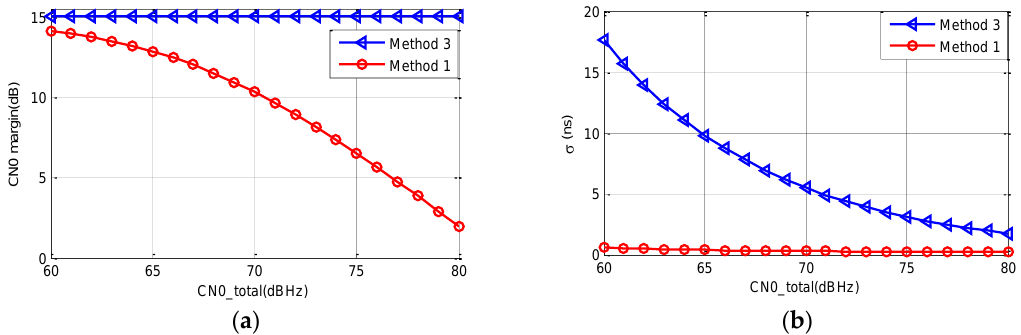
Figure 8. ( a ) CN0 margin versus CN 0 total for methods 1 and 3. ( b ) The accuracy of pseudorange versus CN 0 total for methods 1 and 3.